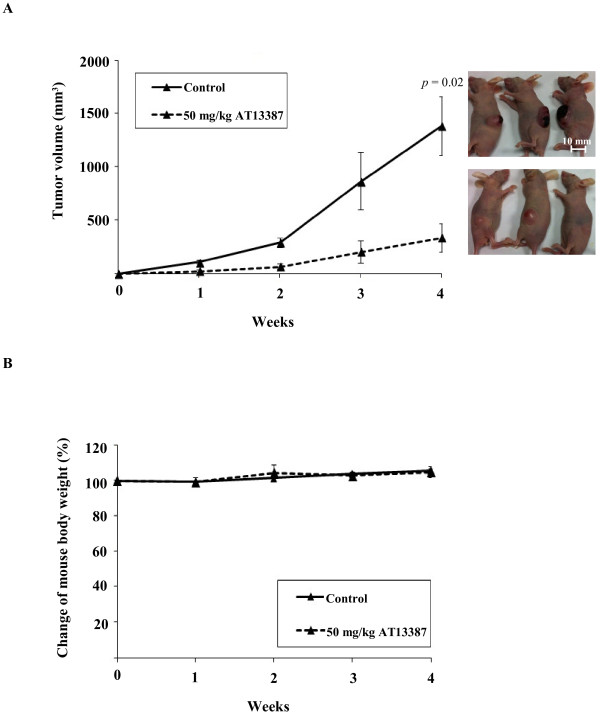
AT13387 suppressed tumor formation in nude mouse tumorigenicity assay. (A) The tumor volume of AT13387-treated mice and vehicle control mice (n = 3) were measured weekly. The solid line represented the average tumor volume of vehicle control group, which reached 1300 mm3 in week 4. The dashed line represents the average tumor volume of AT13387-treated mice which showed significant suppression of tumor formation when compared to vehicle control. (B) The mouse body weight of AT13387-treated mice and control mice during the experiment. The result showed no significant difference for mouse body weight after AT13387 drug treatment group when compared to control group.